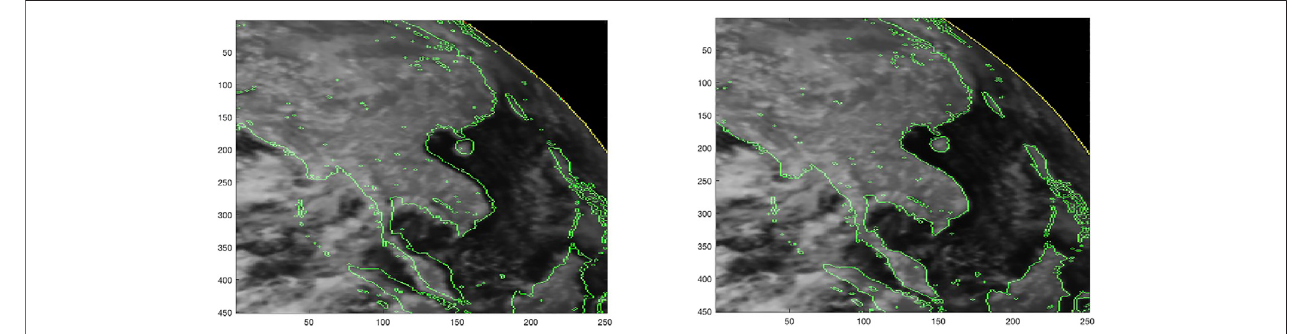
FIGURE 11 | Left: Original, naïve geolocation solution. Right: Improved geolocation solution with back propagation.